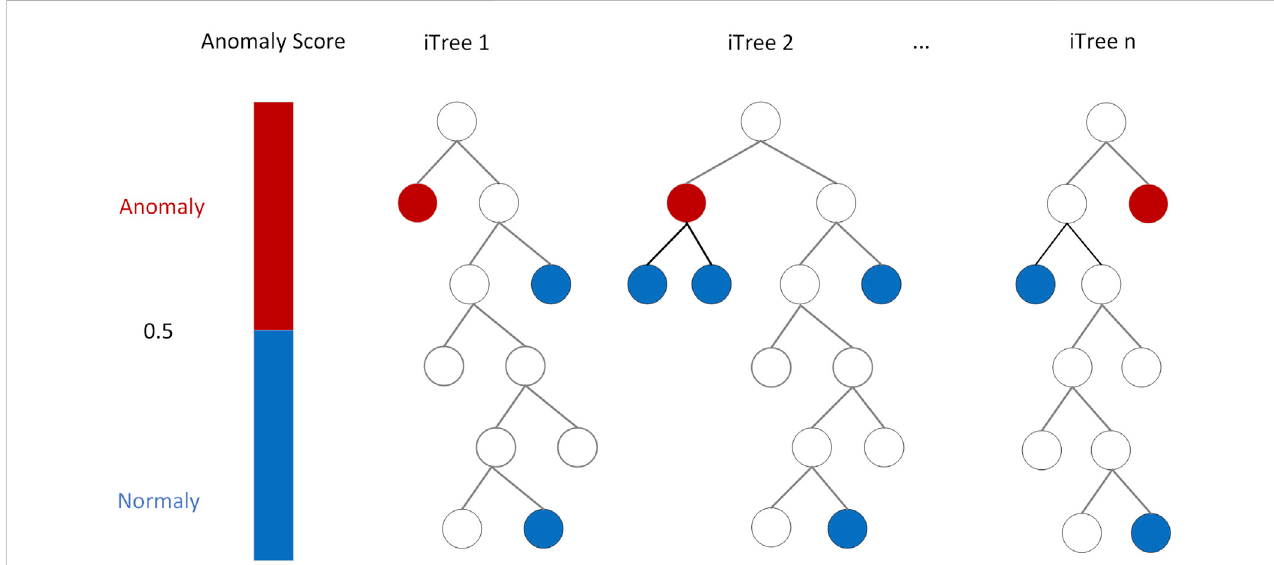
FIGURE 2 Graph example illustrating n trees of an isolate forest. It consists of two steps: step 1. isolation operations of data points using randomly constructed binary search tree; step 2. binary tree with the isolated point. The average path in red is theshortest, the earliest to be distinguished and is probably the outlier